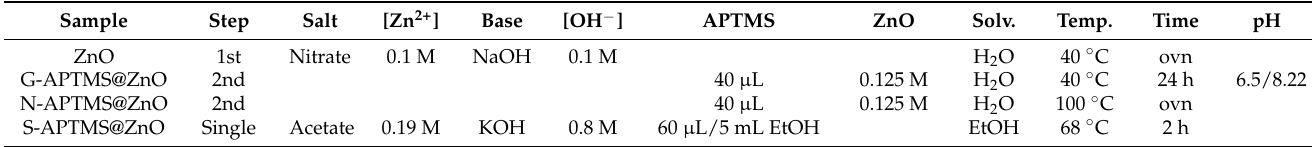
Table 1. Summary of the synthesis conditions. Ovn =